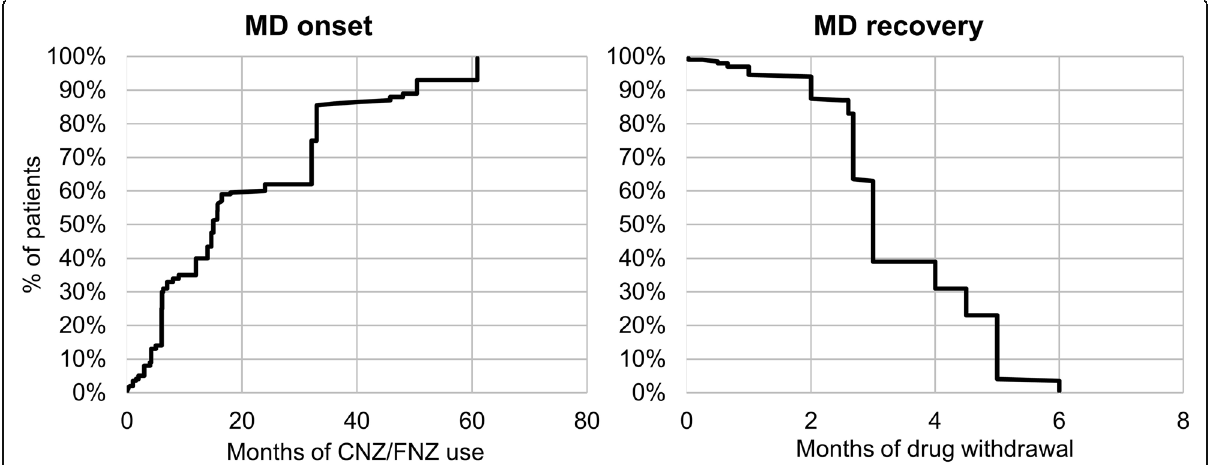
Fig. 5 Comparison between the percentage of patients developing movement disorders (MD) since the beginning of the drug and the percentage of patients recovering after drug withdrawal. The data is from 663 (MD onset) and 473 (MD recovery) individuals reported in the literature